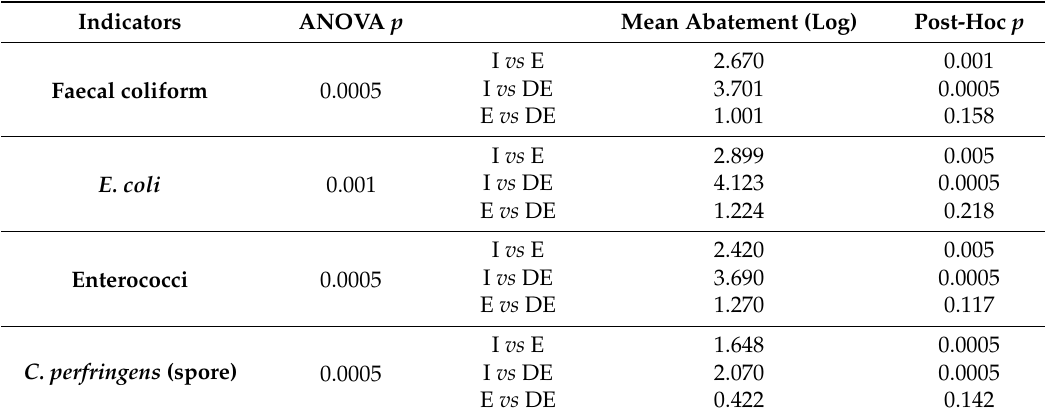
Table 5. Results of the analysis of variance (ANOVA) and post hoc Tukey